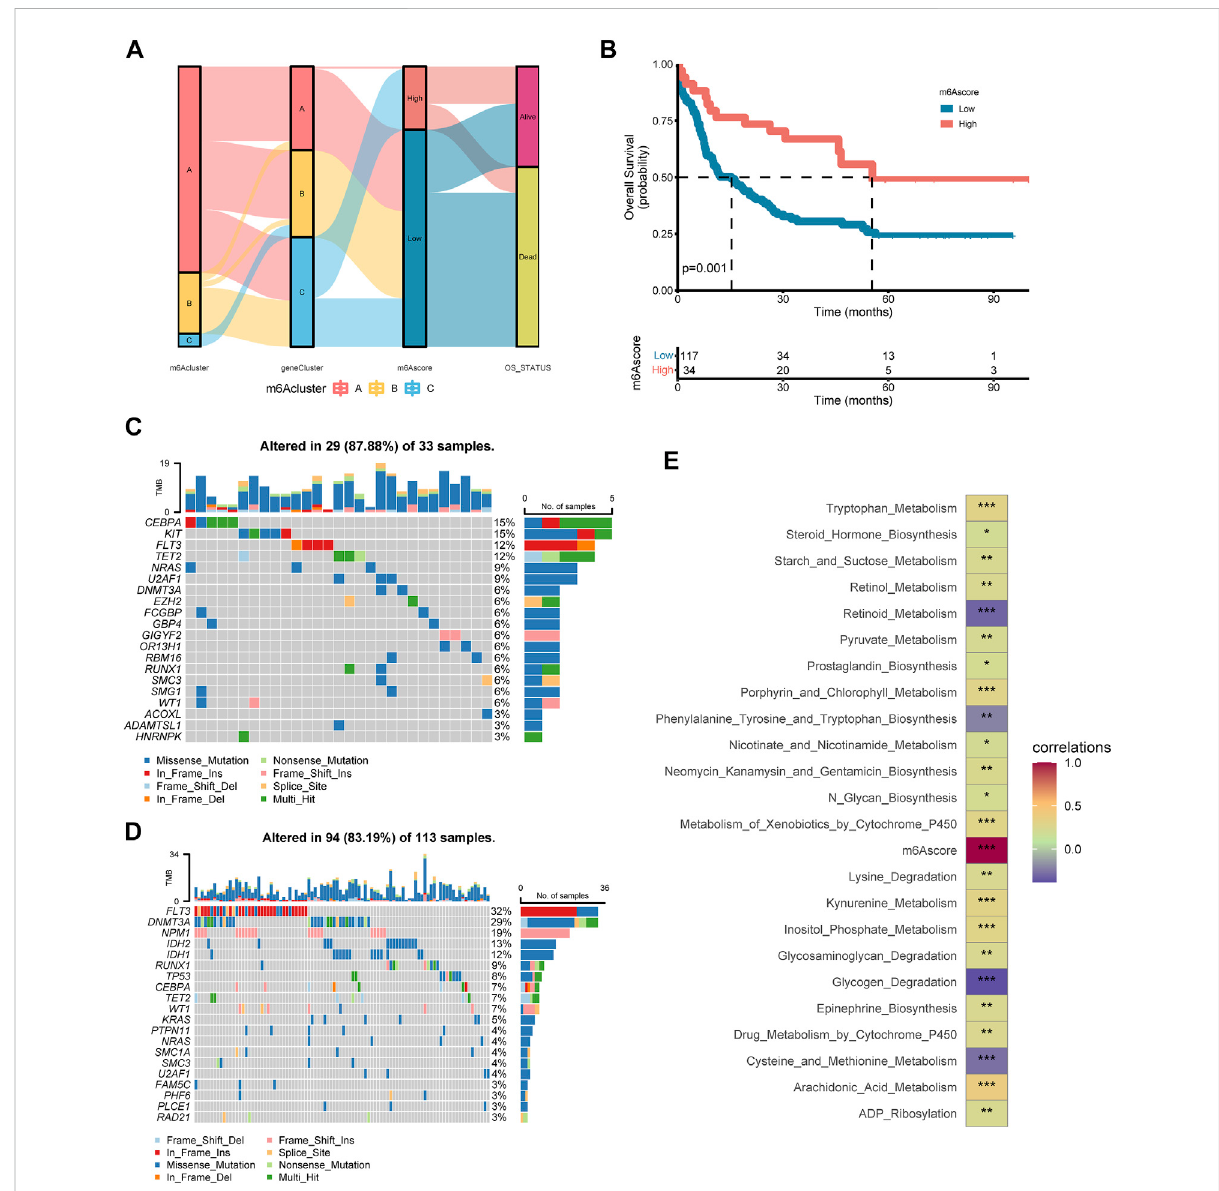
Construction of the m6A score in the training set and the relevance of clinical features (A) Alluvial diagram of subtype distributions in groups withdifferentm6Aclusters,m6Ageneclusters,m6Ascore,andOSstatus (B) Kaplan-Meieranalysis forhighm6Ascoreandlowm6Ascoregroupsin AML cohort ( p = 0.001, Log-rank test) (C – D) Oncoplot visualized the frequently mutated genes in the high m6Ascore group (C) and the low m6Ascoregroup (D) .Intheabovetwo fi gures,thetop20mutatedgenesweredistributedverticallybyreducingmutationfrequencyfromtopto bottom (E) Functional annotation for m6Ascore using GSVA enrichment analysis. The intensity of the colors represents the strength of